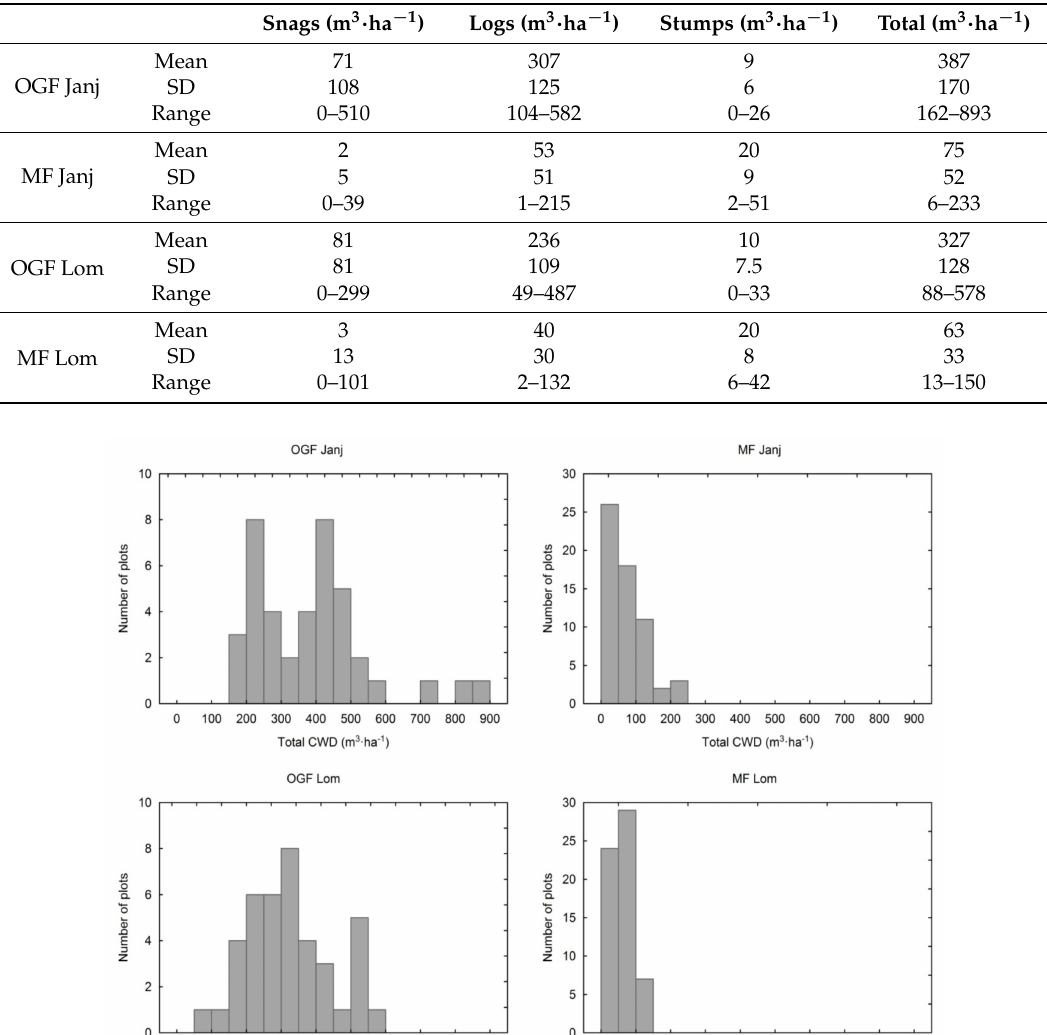
Table 2. Mean, standard deviation (SD), and range values for coarse woody debris in old-growth forests (OGFs) and managed forests (MFs) in Janj and Lom.